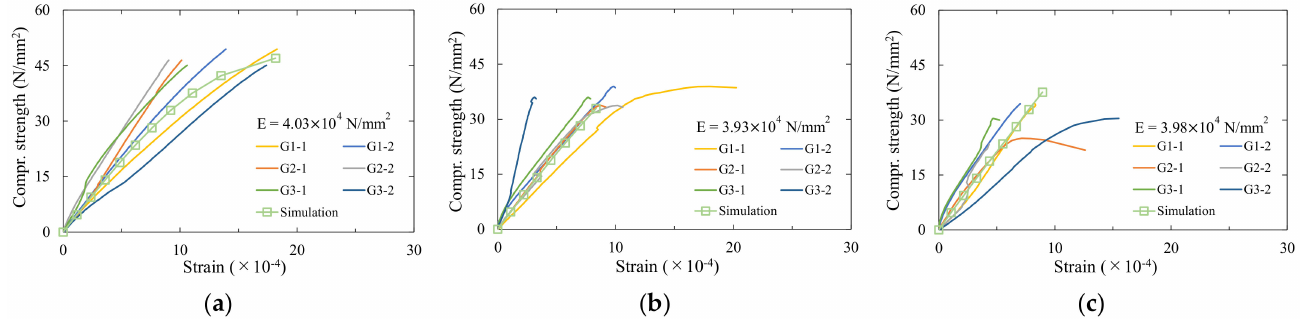
Figure 19. The density and compressive strength of 2009 CS concrete.